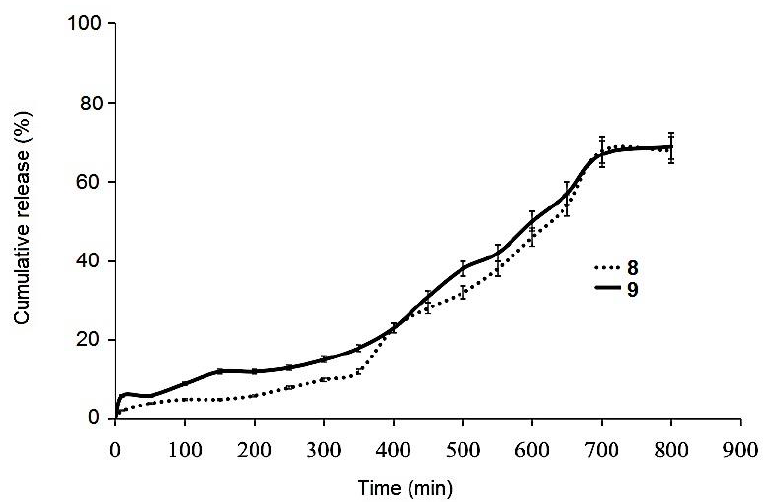
Figure 4. Release of drug from compound 8 (dotted line), and from compound 9 (continuous line) as a function of time and pH (pH 7.4, 37 ° C).